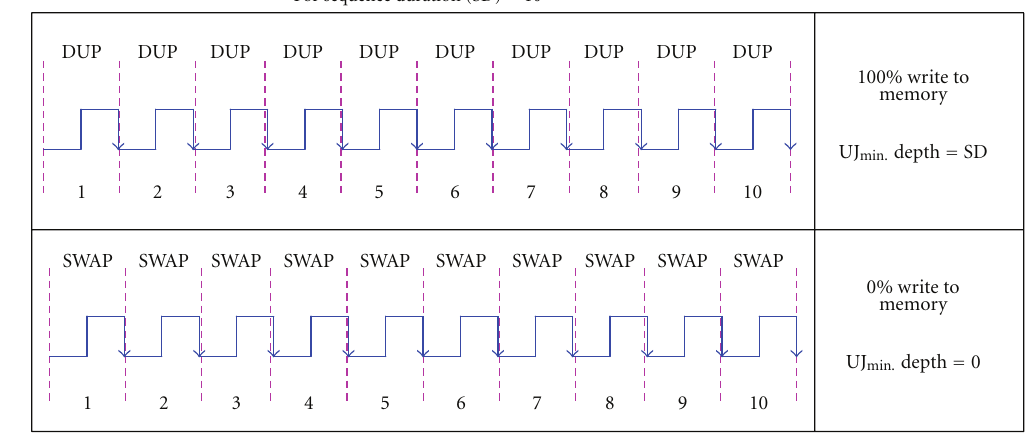
Figure 16: “Writes” rate for 2 di ff erent benchmarks.